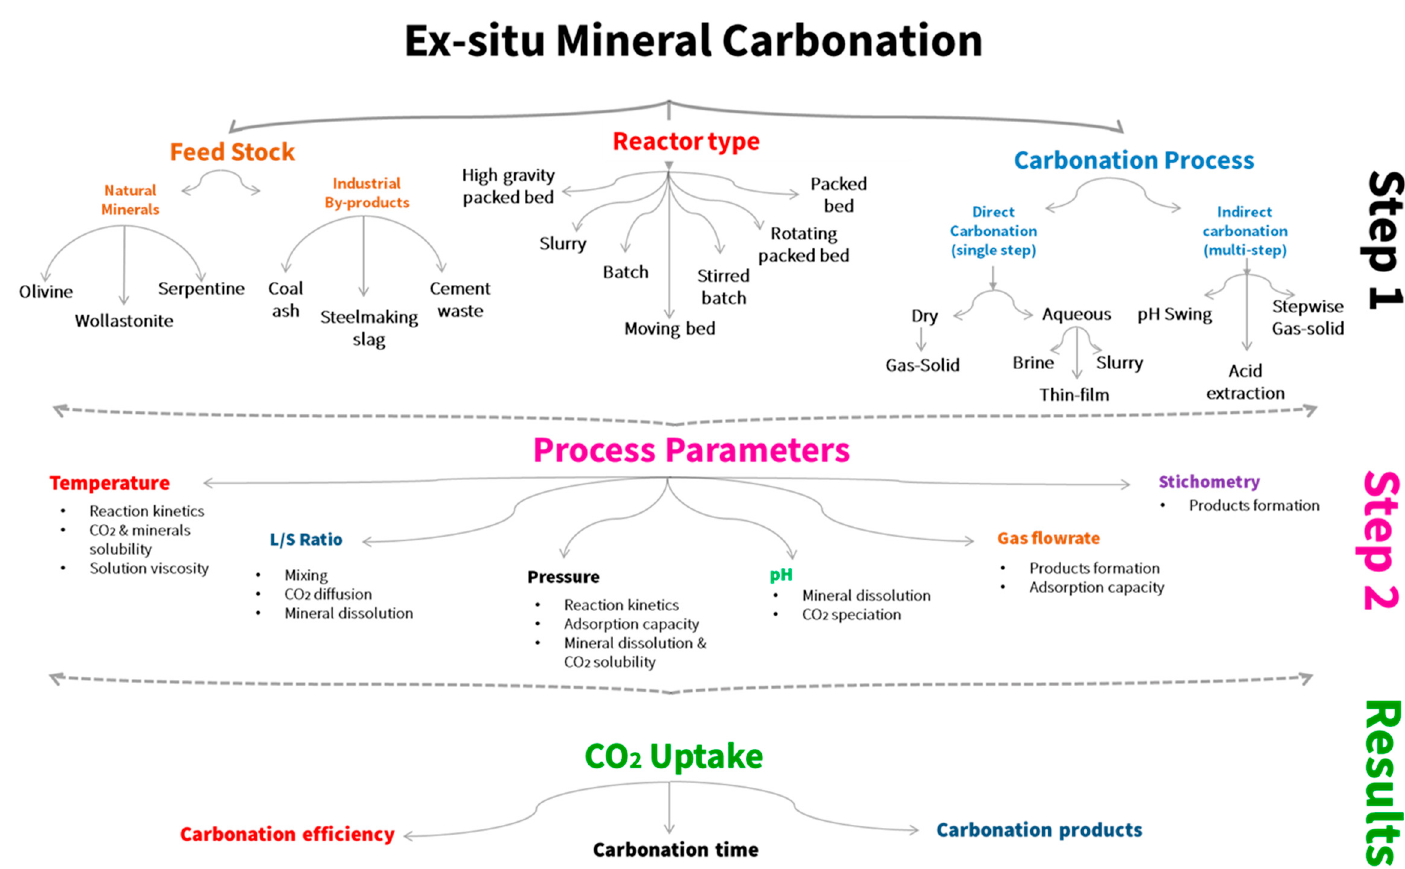
Figure 1. Ex-situ mineral carbonation literature summary.